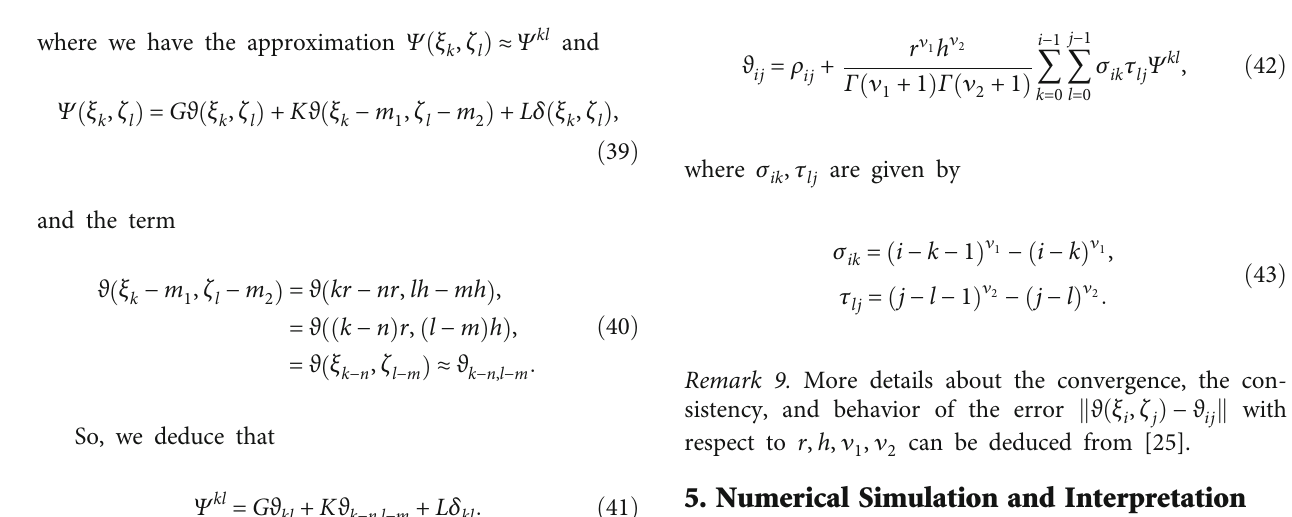
ϑ 1 and 2 are represented in (a) and (b),